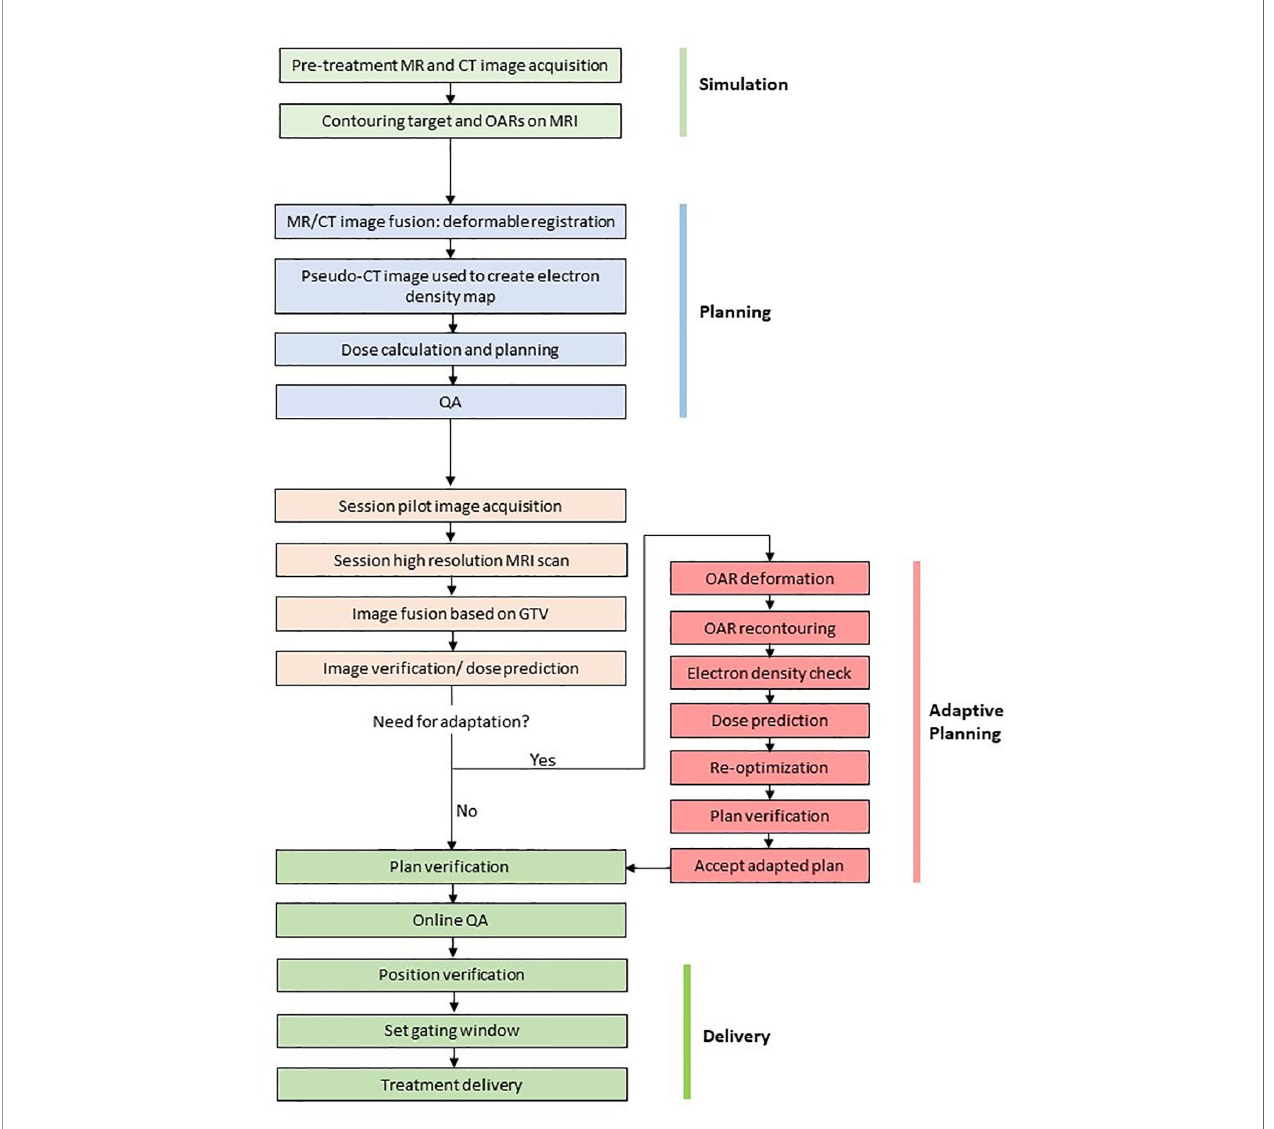
FIGURE 4 | Example work fl ow for the